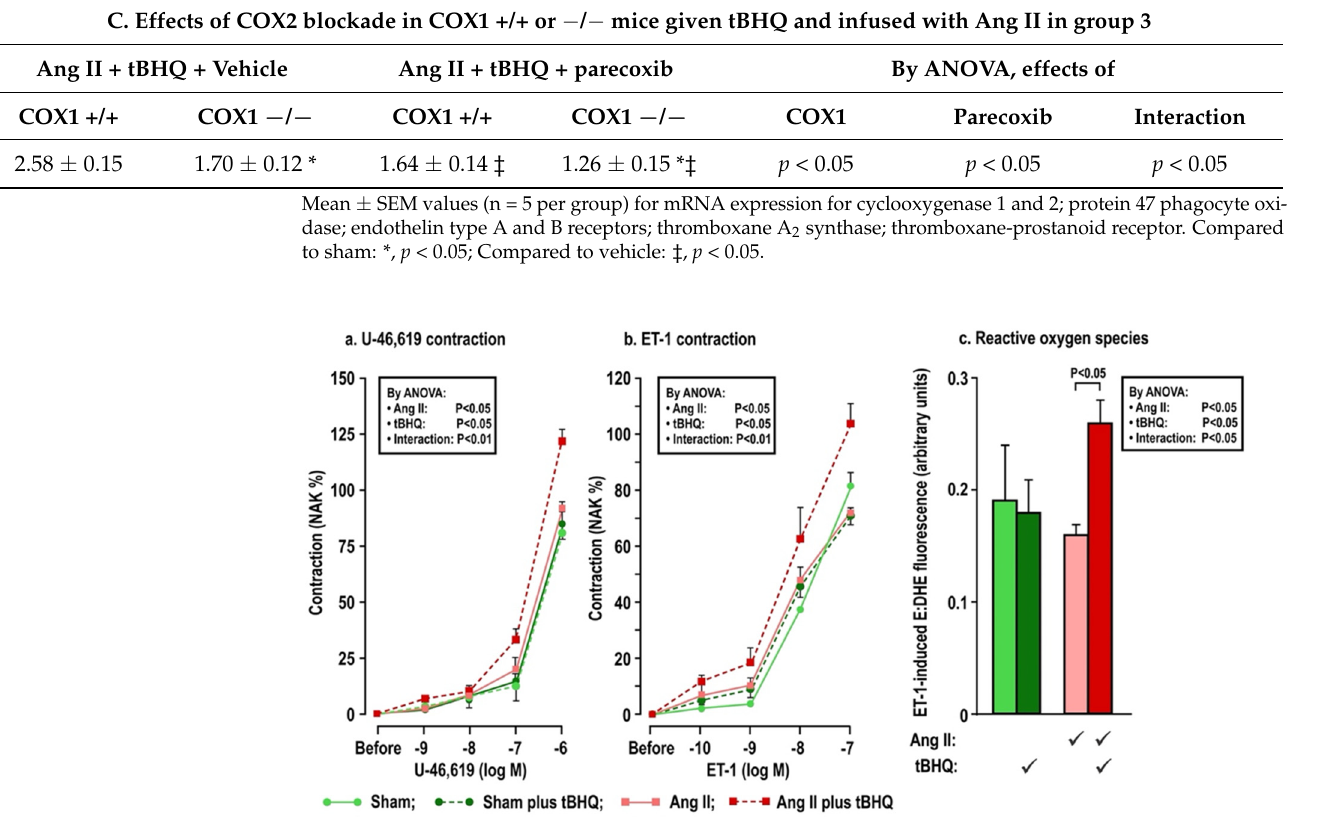
Figure 2. Oral tBHQ given to mice during a three day infusion of angiotensin II enhances the contractions to thromboxane (Panel a ) and endothelin-1 (Panel b ) and the reactive oxygen species generation with endothelin-1 (Panel c ) in mesenteric microarterioles from C57Bl/6 mice. Mean ± SEM values (n = 6 per group) in mesenteric microarterioles from mice of group 1 depicting dose-dependent contraction to thromboxane and endothelin 1 and reactive oxygen species generation from the ratio of ethidium to dihydroethidium fluorescence during incubation with endothelin 1 (10 − 7 mol·L − 1 ). ET-1, endothelin 1; ROS, reactive oxygen species; NAK, standard contraction with norepinephrine + KCl; tBHQ, tert-butylhydroquinone (0.1% added to drinking water × 3 days); Ang II